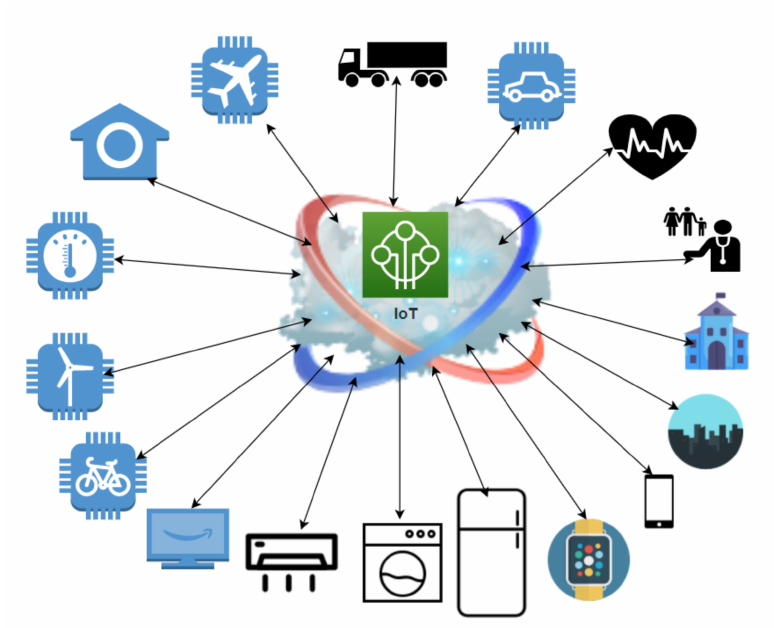
Figure 2. Cloud-IoT applications main